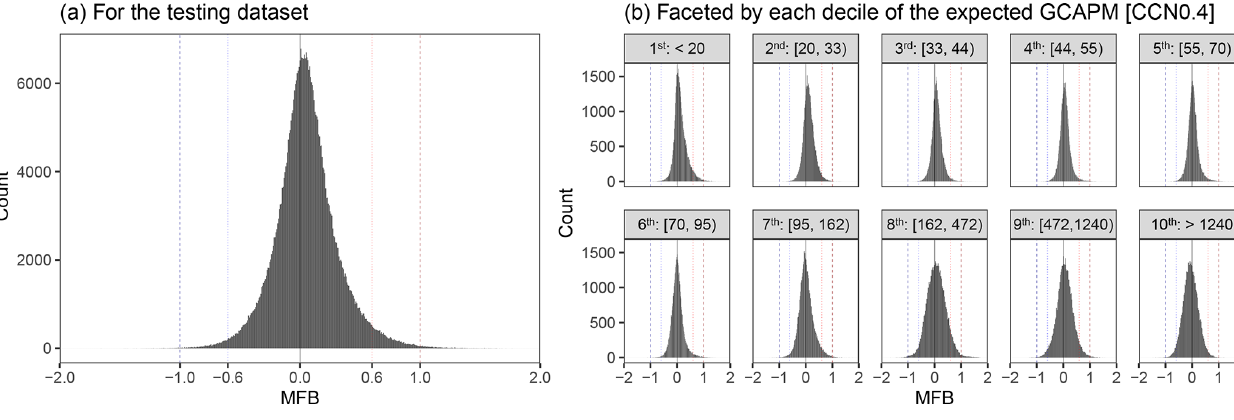
Figure 9. Mean fractional bias (MFB) of RFRM derived [CCN0.4] compared to expected values from GCAPM in the testing dataset (441756 values). Histogram shows the counts of the pairs by MFB. The lines indicate perfect agreement (black), MFB of + 1 (dashed red), and MFB of − 1 (dashed blue). The dotted lines indicate MFB of + 0 . 6 (dotted red) and − 0 . 6 (dotted